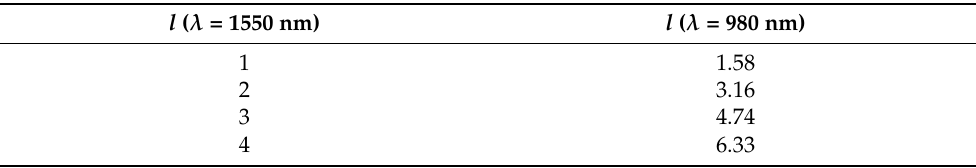
Table 2. SPP orders at different